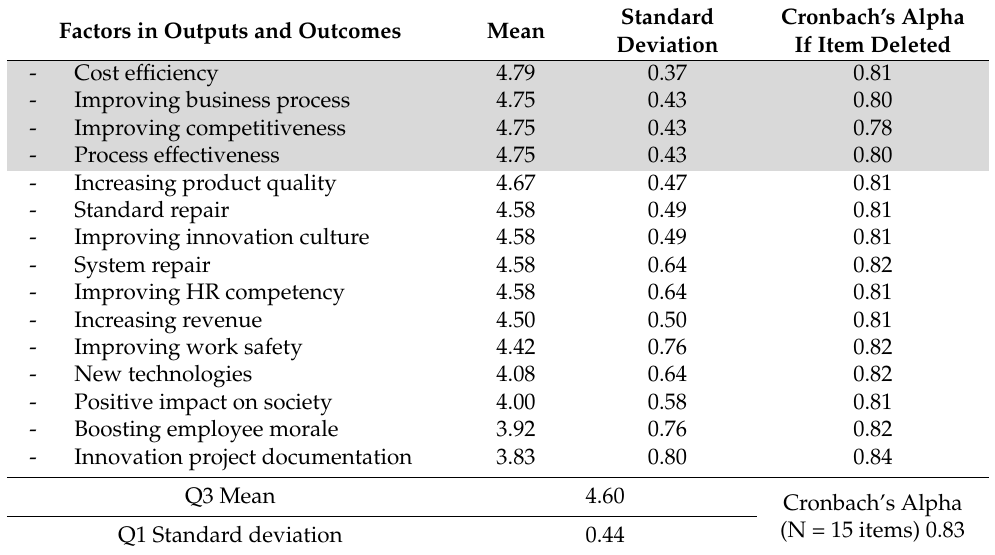
Table 7. Calculation of Q3 mean and Q1 standard deviation of outputs and outcomes indicator factors.